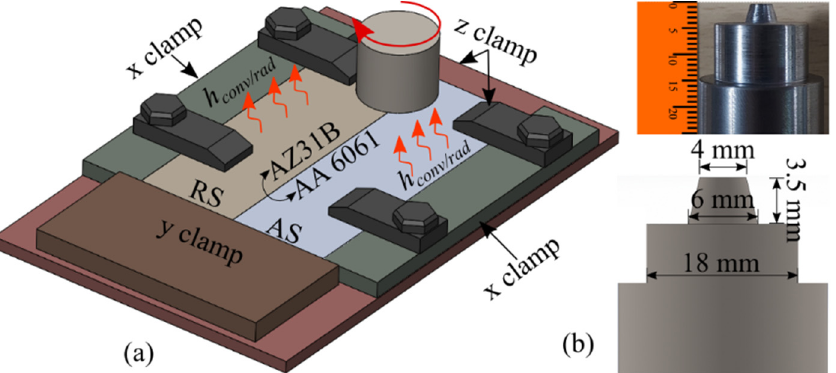
Figure 1. ( a ) A schematic of dissimilar FSW and ( b ) the detailed dimensions of the tool used for FSW. Table 3. Details of the experimental process parameters and plate positions.